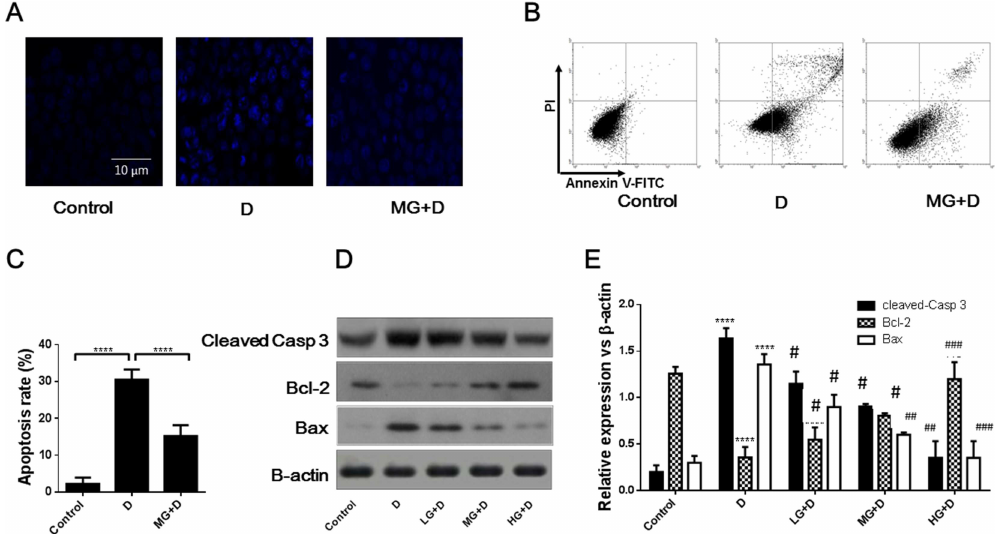
Fig 2. Protectiveeffect of GB against DOX induced cardiomyocytes apoptosis. ( A ) Representative images of Hoechst nuclear staining in each group. The extent of nuclear damagewas decreased in the group of GB pretreatment for 30 min followedby DOX-induced cardiotoxicity comparatively to the DOX group. ( B ) Flow cytometry analysisof the cardiomyocytes apoptosis.Protective effects of GB pretreatment on the apoptosisof cardiomyocytes were demonstrated by AnnexinV/PI staining.( C ) Quantitativerepresentation of the flow cytometry analysis. Cardiomyocytes apoptosiswas inhibitedfollowingGB pretreatment for 30 min before DOX-induced cardiotoxicity. ( D ) and ( E ) Western-blot analysisof apoptosisrelated proteins (cleavedcaspase 3, Bcl-2 and Bax) in cardiomyocytes after GB pretreatment for 30 min prior to DOX-induced cardiotoxicity. **** p < 0.0001 when comparedto control group, #p < 0.05##p < 0.01, ###p < 0.001when comparedto the DOX group.